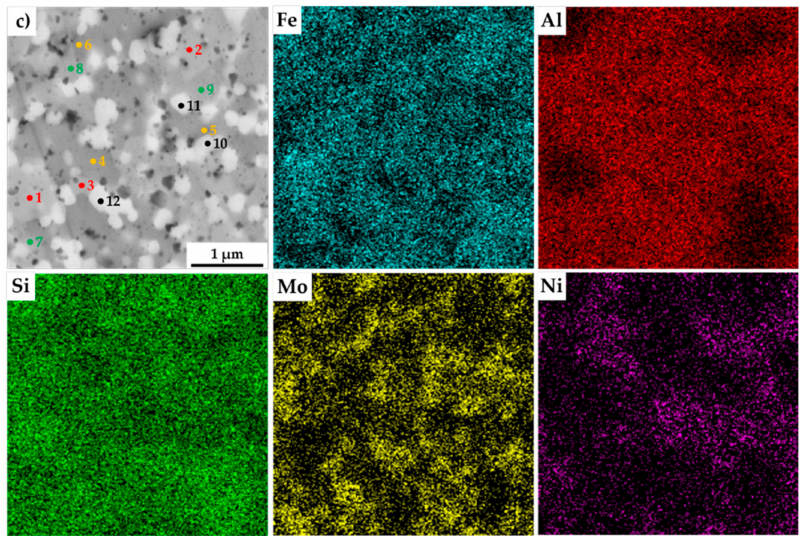
Figure 4. SEM + EDS element distribution maps of the MA + SPS: ( a ) FeAl20Si20Mo5Ni15; ( b ) FeAl20Si20Mo10Ni10; ( c ) FeAl20Si20Mo15Ni5 alloys with the marked places of chemical